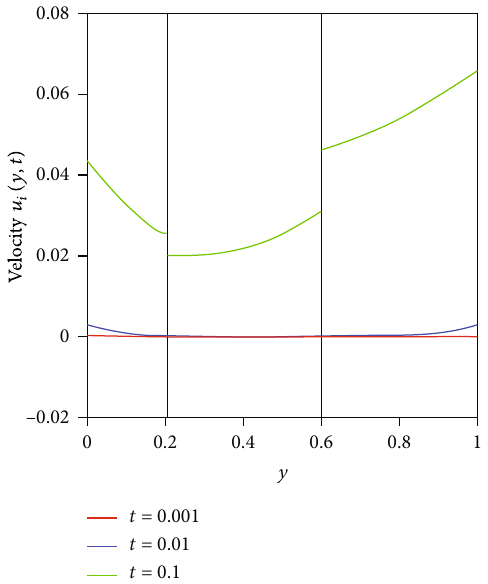
Figure 13: The pro fi les of velocity u ð y , t Þ , i = 1, 2, 3, for small i = 0 : 4, α = 0 : 6, α = 0 : 8 values of the time t ( α 1 2 3 = 1, a = 1 : 3, a = 1 : 5, b = 1, b = 4, b = 12 , h = 0 : 2 , h = 0 : 6, a 1 2 3 1 2 3 1 2 and λ = 0 : 021, λ = 0 : 042, λ = 0 : 060 1 2 3